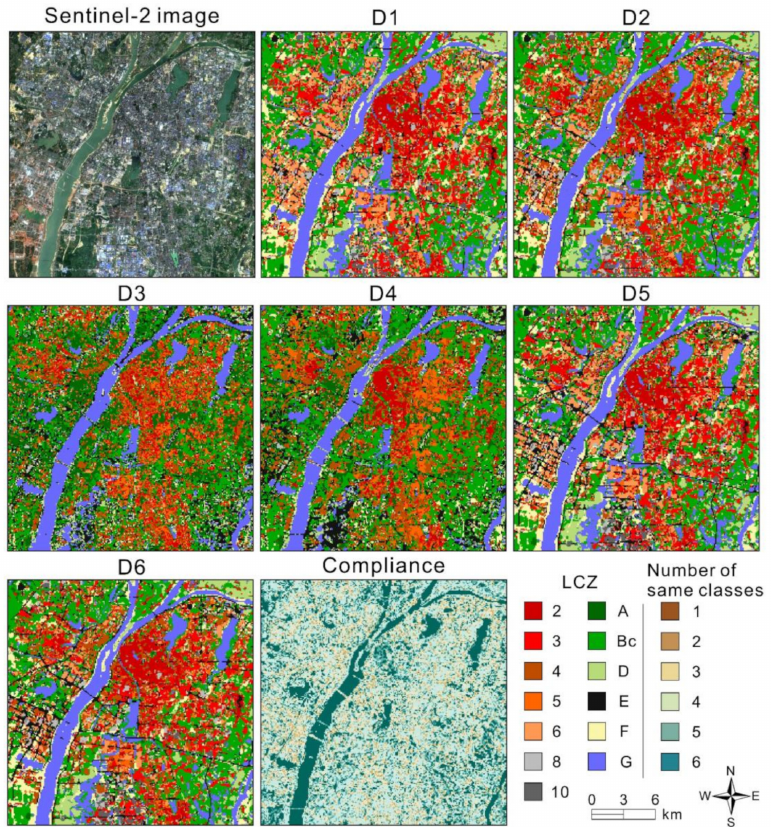
Figure 7. Sentinel-2 MSI image (RGB = bands 4, 3, 2) and LCZ classification maps using six datasets ( D1 – D6 ) of a subregion A in the urban district of